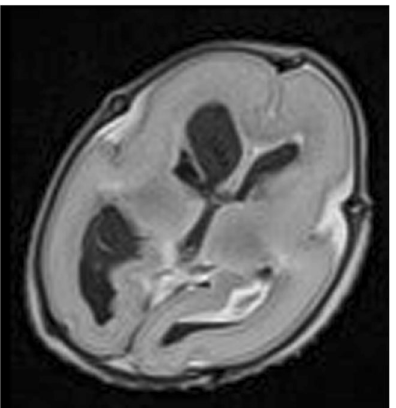
Fig. 3 Axial T2-W image of the brain of a 20 weeks fetus showing bilateral intraventricular hemorrhage as a normal postmortem change